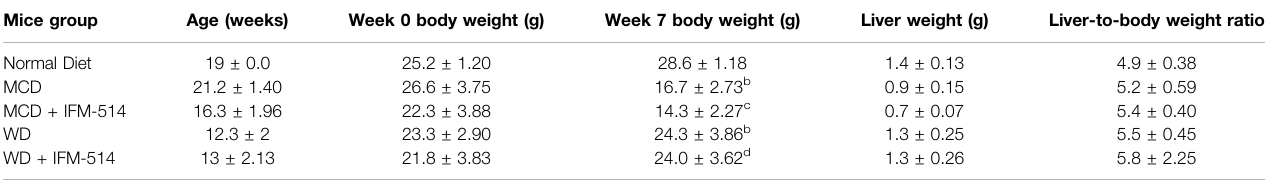
TABLE 1 | Age, body weight (week 0 and 7), liver weight and liver-to-body weight ratio of ApoE -/- mice receiving normal diet, MCD, WD and IFM-514-treated MCD-fed and WD-fed mice. Mice group Age